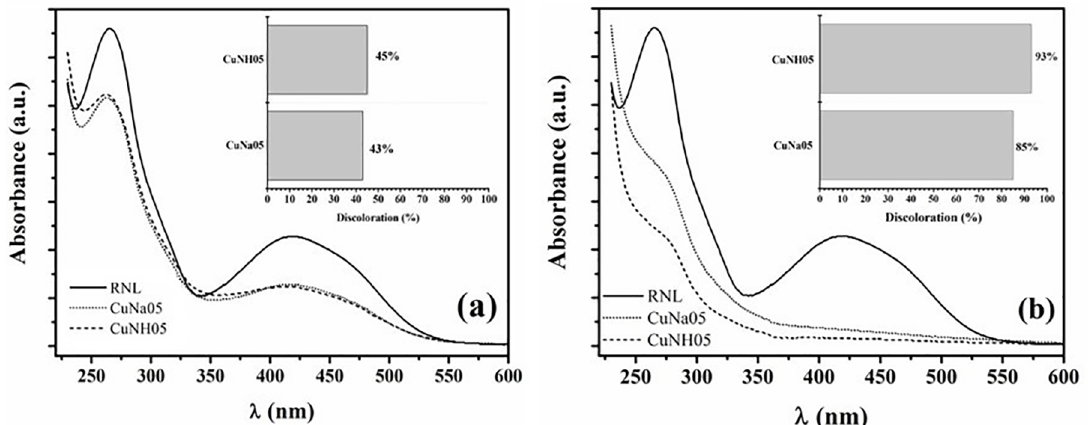
Figure 7. UV-vis spectra of RNL azo-dye, after adsorption (a) and after photocatalytic. test (b), in the presence of CuNa05 and CuNH05 (inset: percentage of